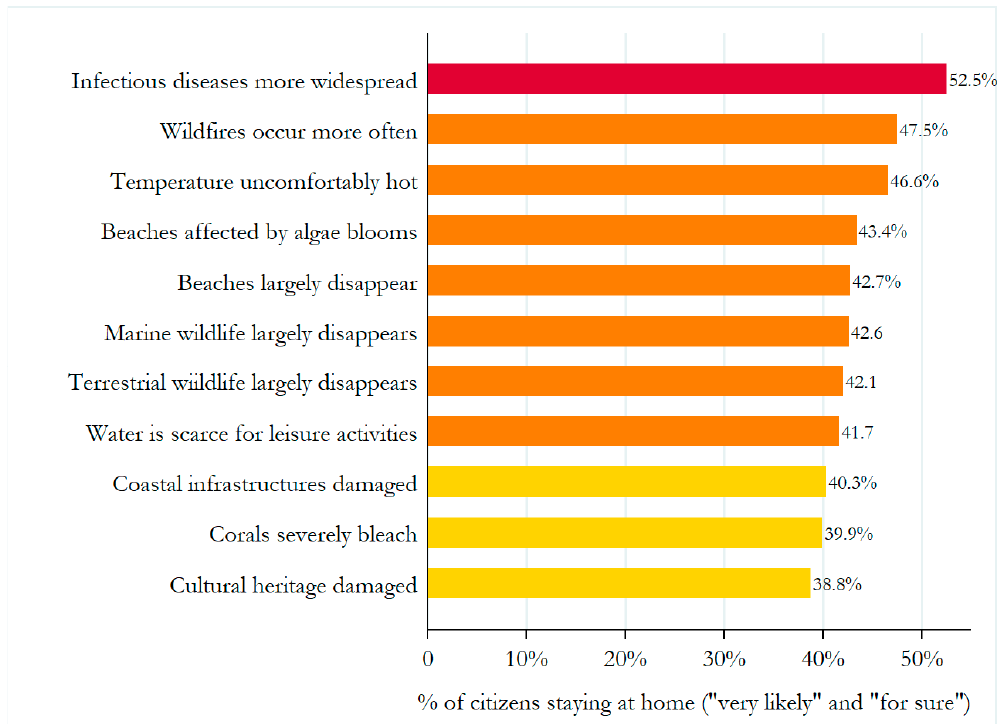
Figure 3. Tourists’ decisions to stay at home if islands are affected by climate change impacts.